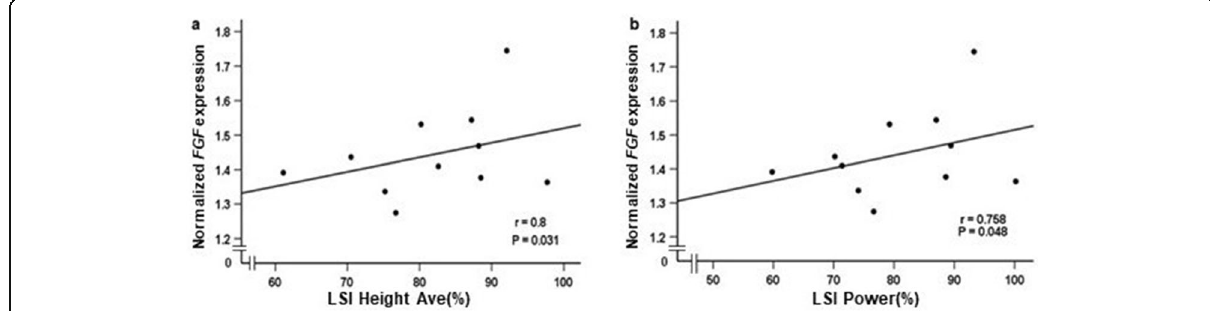
Fig. 4 Associations among biomarker gene expression and HRT categories. Correlations between ( a ) FGF gene expression and LSI average height and, b FGF gene expression and LSI power measured by Spearman ’ s rank correlation coefficient. HRT categories ranges from 0 to 100, with 100 = best outcome. n =